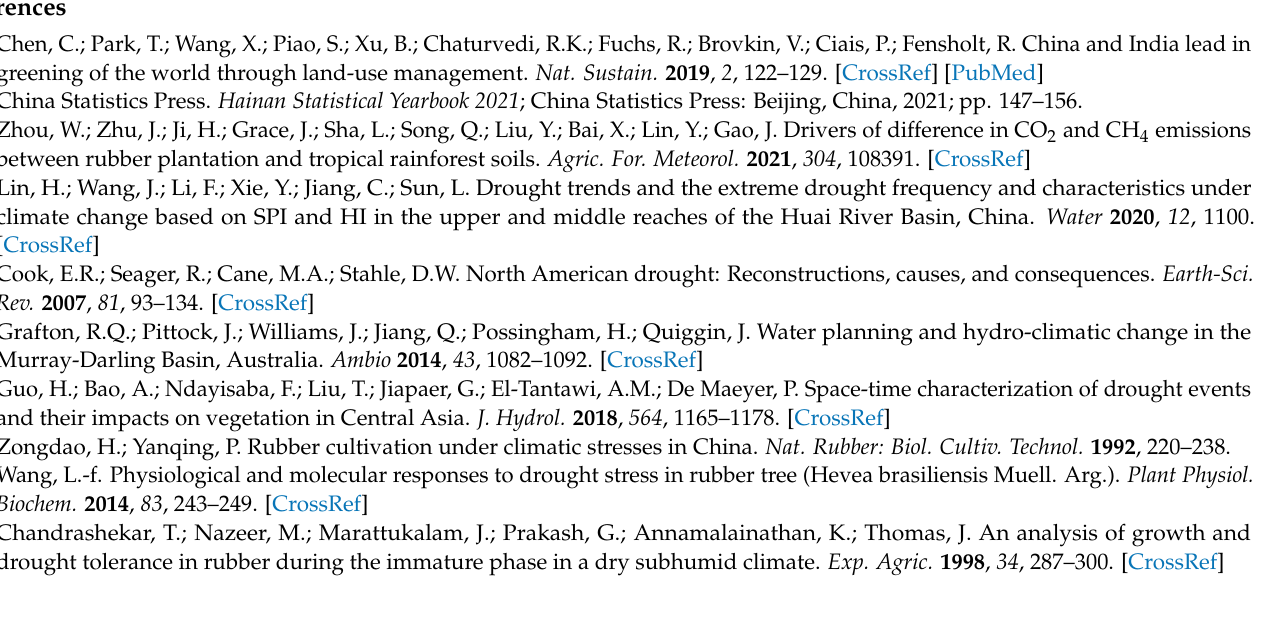
Figure S12: Spatial distribution of Rubber plantation’s GPP loss in June under the different drought intensities over Hainan Island; Figure S13: Spatial distribution of Rubber plantation’s GPP loss in July under the different drought intensities over Hainan Island; Figure S14: Spatial distribution of Rubber plantation’s GPP loss in August under the different drought intensities over Hainan Island; Figure S15: Spatial distribution of Rubber plantation’s GPP loss in September under the different drought intensities over Hainan Island; Figure S16: Spatial distribution of Rubber plantation’s GPP loss in October under the different drought intensities over Hainan Island; Figure S17: Spatial distri- bution of Rubber plantation’s GPP loss in November under the different drought intensities over Hainan Island; Figure S18: Spatial distribution of Rubber plantation’s GPP loss in December under the different drought intensities over Hainan